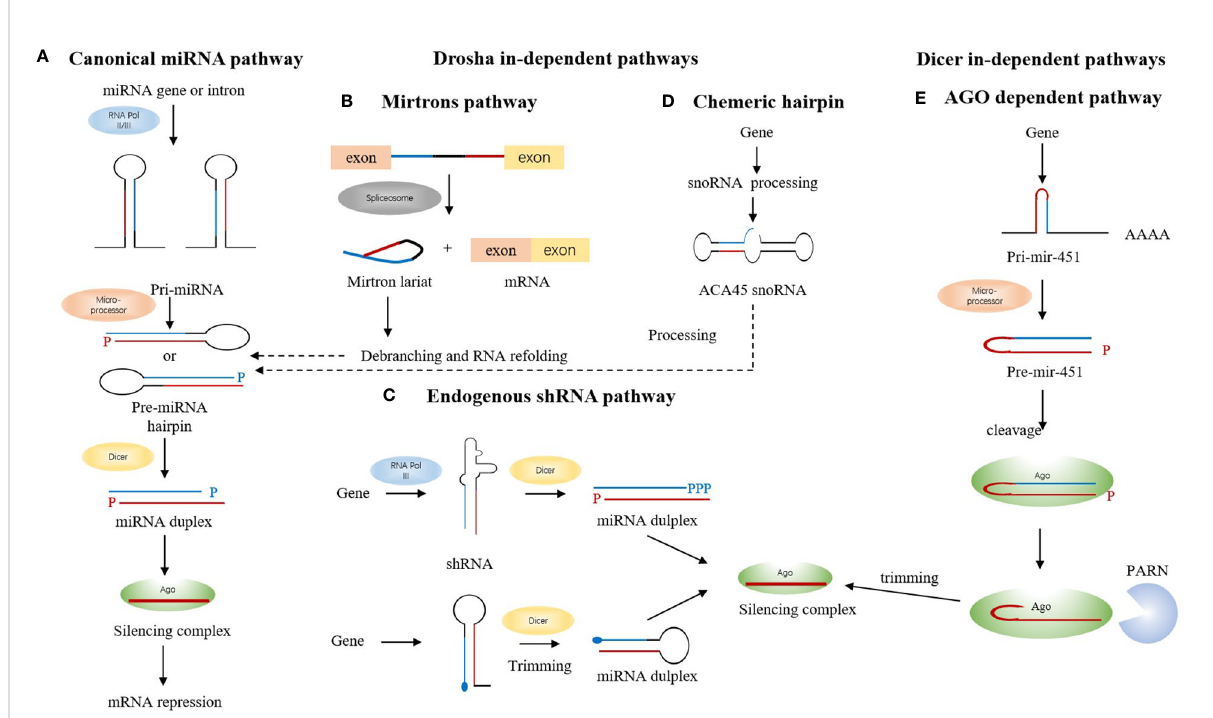
FIGURE 1 The biogenesis of miRNA. (A) miRNA genes are transcribed to pri-miRNA, which are then processed by a microprocessor complex to generate pre-miRNA. After getting exported to the cytoplasm via exportin-5, pre-miRNAs are subsequently processed to mature miRNAs by RNase III Dicer and then loaded onto the Ago to form the effector RISC, which represses translation. (B) Mirtrons are located in the introns of the mRNA encoding host genes, which arise from the spliced-out introns. The short hairpin introns use splicing to bypass Drosha cleavage. Mirtron lariat can enter the canonical miRNA pathway after debranching and RNA refolding. (C) After getting trimmed by Dicer, shRNA forms the miRNA duplex and then gets transported onto Ago to form the silencing complex. (D) snoRNAs like ACA45 snoRNA is processed into canonical miRNA pathway ultimately associated with Ago 1 and 2. (E) miR-451 is processed by microprocessor complex and does not require